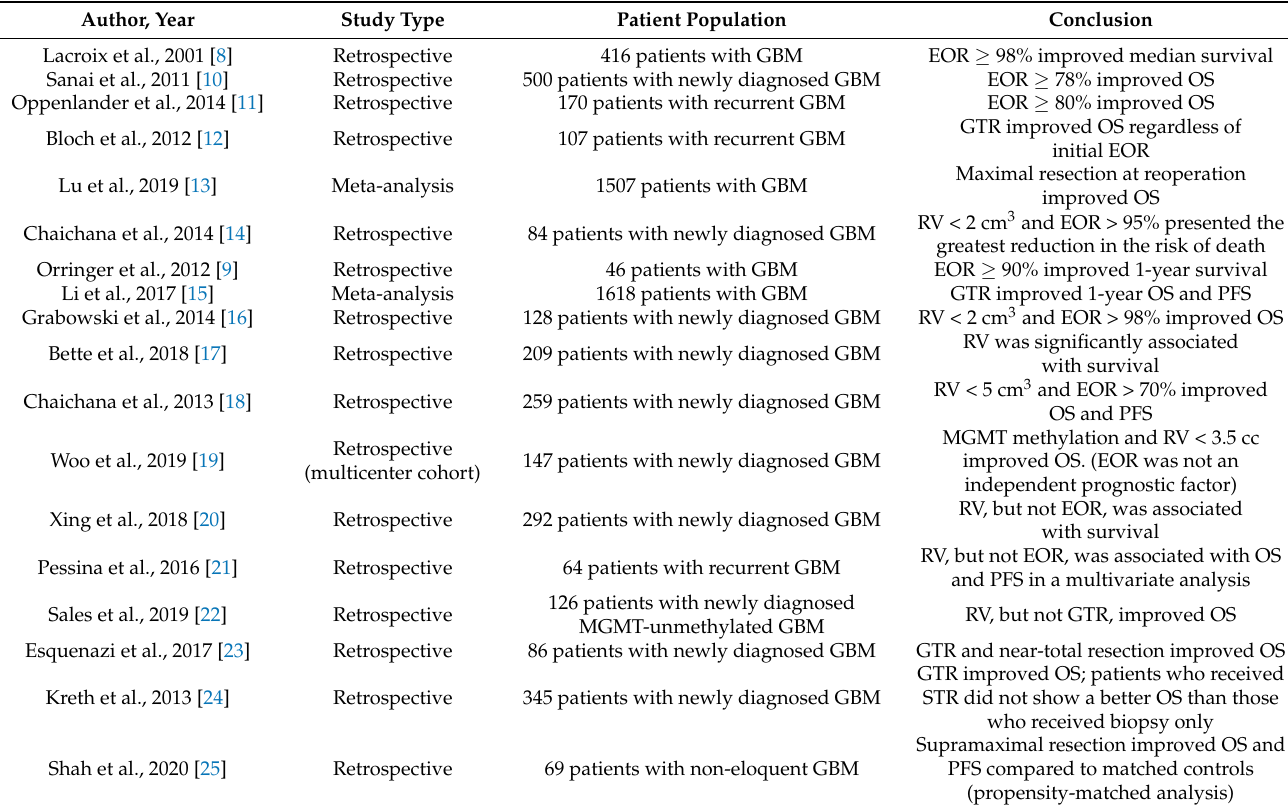
Table 1. Main studies evaluating EOR and RV in patients with